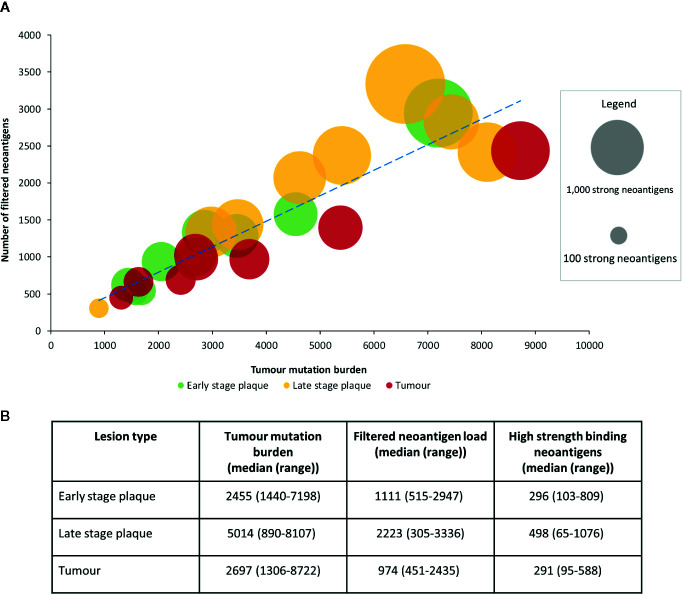
Relationship between tumor mutation burden and filtered neoantigen load in mycosis fungoides (MF). (A) A strong positive linear association (r=0.92, blue dashed trendline) was observed between tumor mutation burden and filtered neoantigen load. Each bubble represents a single sample, with its size proportional to the number of high strength neoantigens (<0.05%rank). A positive linear association was also observed between tumor mutation burden and the high strength neoantigen load (r=0.81). (B) Mutations and neoantigen numbers by lesion type.